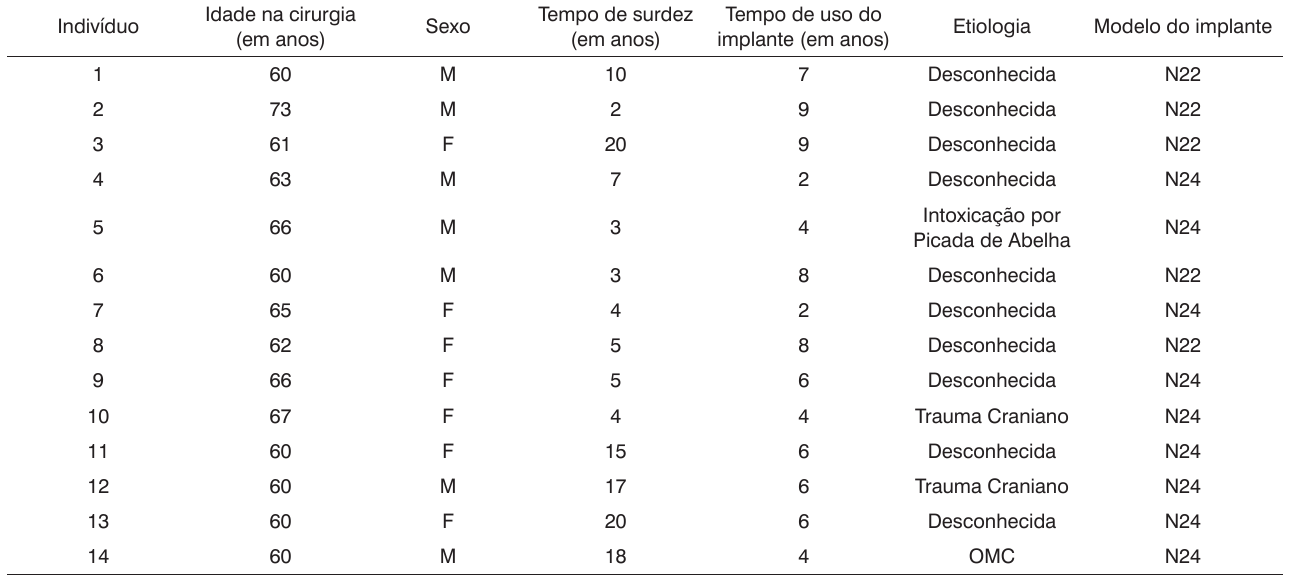
Tabela 1. Dados demográficos dos participantes do